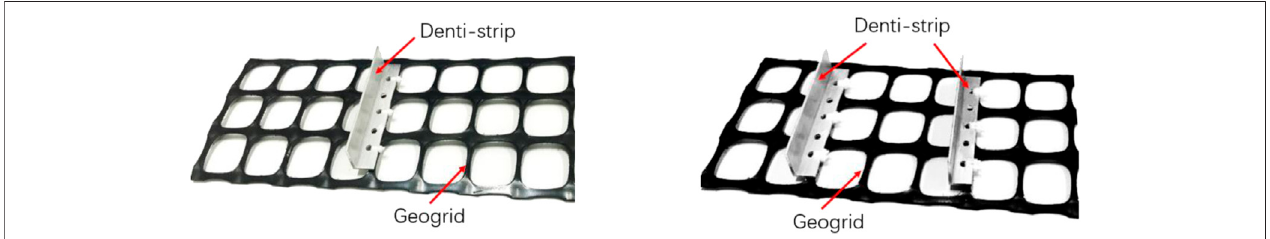
FIGURE 4 | Denti-geogrid specimens.